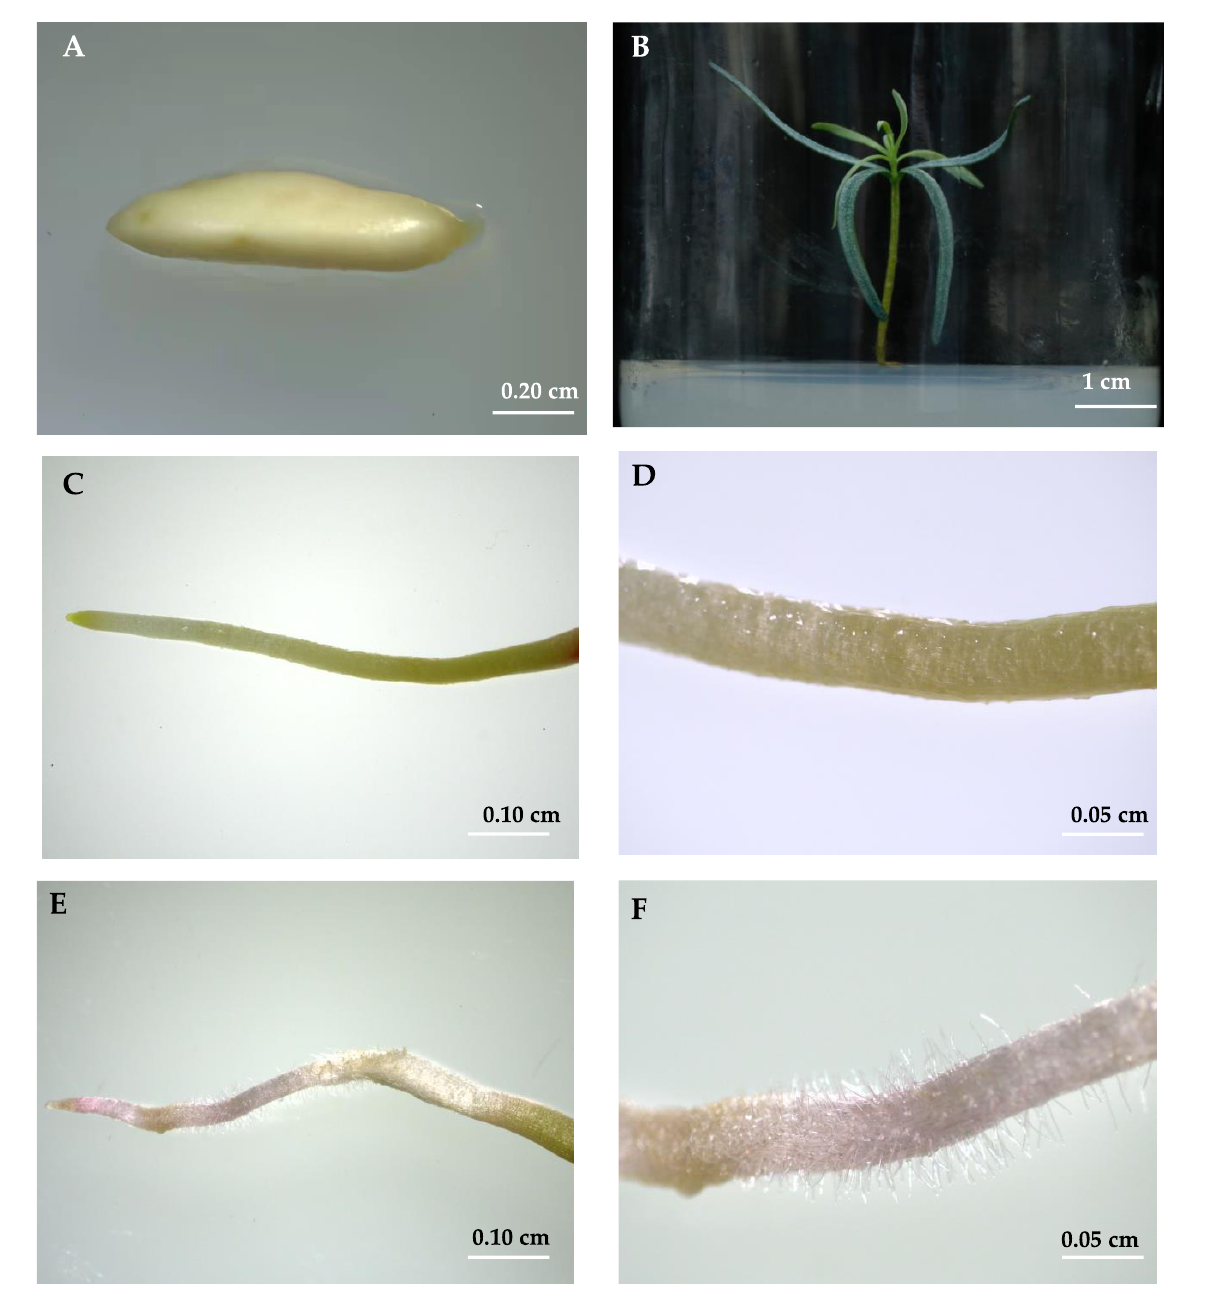
Figure 1. Phenotypes of test-tube plantlets of A. beshanzuensis . ( A ) Immature embryo of A. beshanzuensis . Bar, 0.20 cm. ( B ) The test-tube plantlet of A. beshanzuensis. Bar, 1 cm. ( C ) Radicles without root hair of A. beshanzuensis . Bar, 0.10 cm. ( D ) Zoom of radicles without root hair of A. beshanzuensis. Bar, 0.05 cm. ( E ) Radicles with root hair of A. beshanzuensis . Bar, 0.10 cm. ( F ) Zoom of radicles with root hair of A. beshanzuensis. Bar, 0.05 cm.